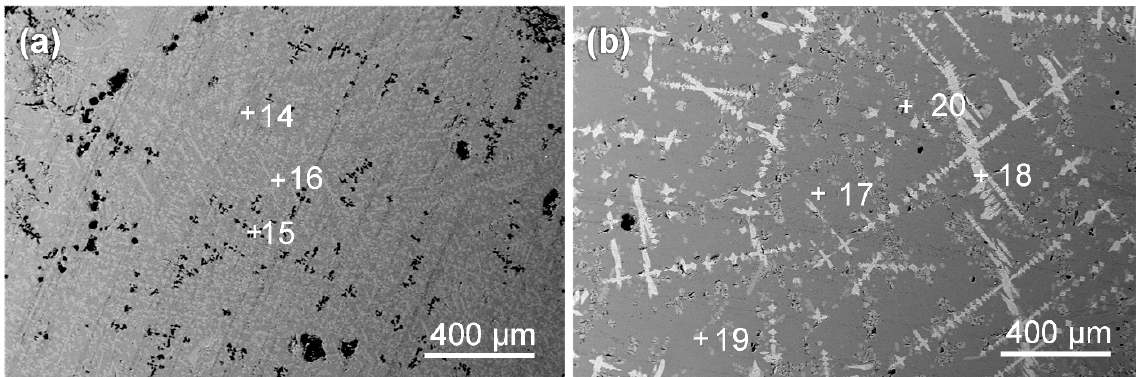
Figure 10. Morphologies of slags with different TiO 2 contents ( R = 6, 1310 °C): ( a ) Slag A1, w (TiO 2 ) = 0%; ( b ) Slag A5, w (TiO 2 ) = 10%.